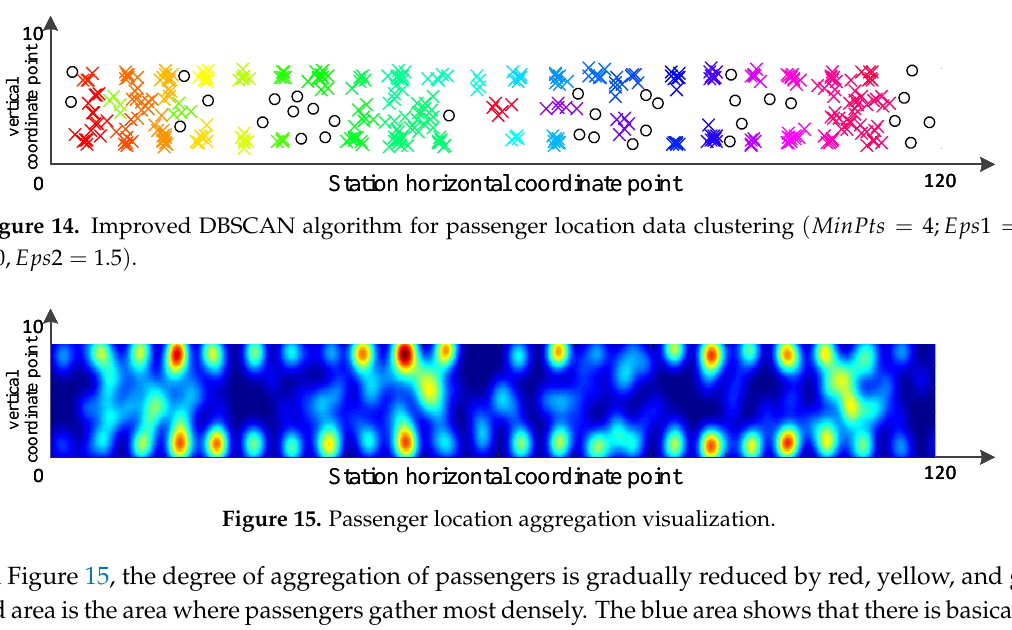
Figure 13. Schematic diagram of passenger location data density level division.